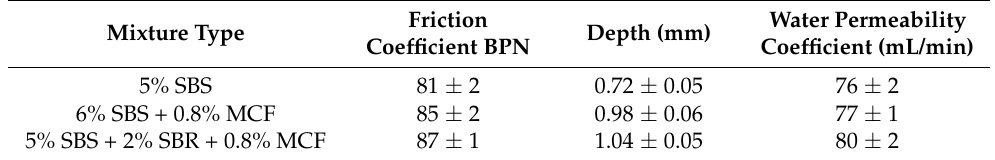
Table 10. Results of anti-slip and water seepage